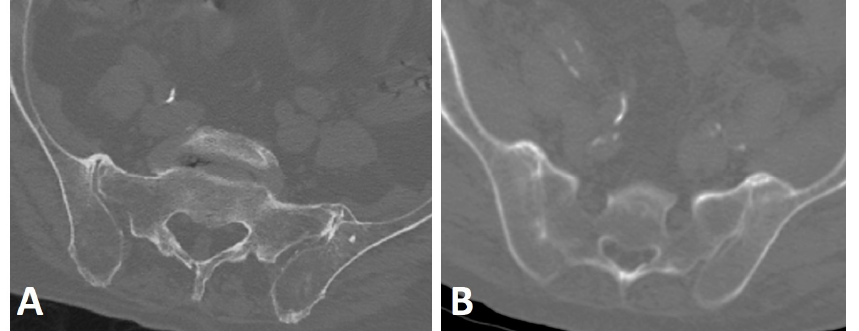
Figure 7. Axial CT images of the SIJs of two patients with DISH. ( A ) Characteristic extra-articular bridging osteophytes are seen anterior to the SIJs. ( B ) In addition to the ventral extra-articular osteophytes, clear ankylosis can be observed within the right and left SIJs.